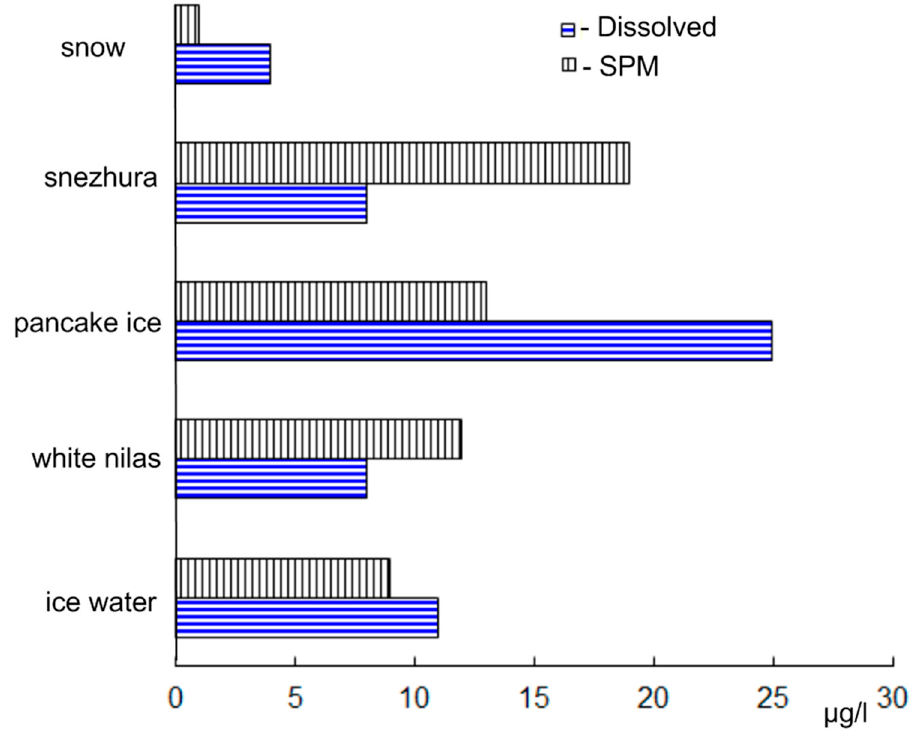
Figure 11. AHC redistribution between dissolved and SPM forms in the “young ice”.